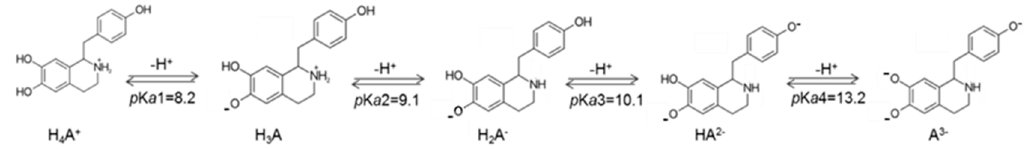
Table 1. Molar fractions (M 𝑓(cid:4667) of the different acid–base species of higenamine at physiological pH.